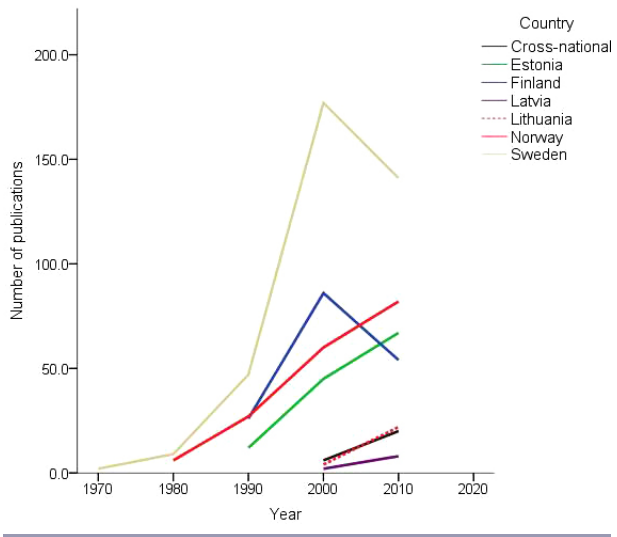
Fig. 5 . Research time line according to country concerning semi-natural habitats by publication